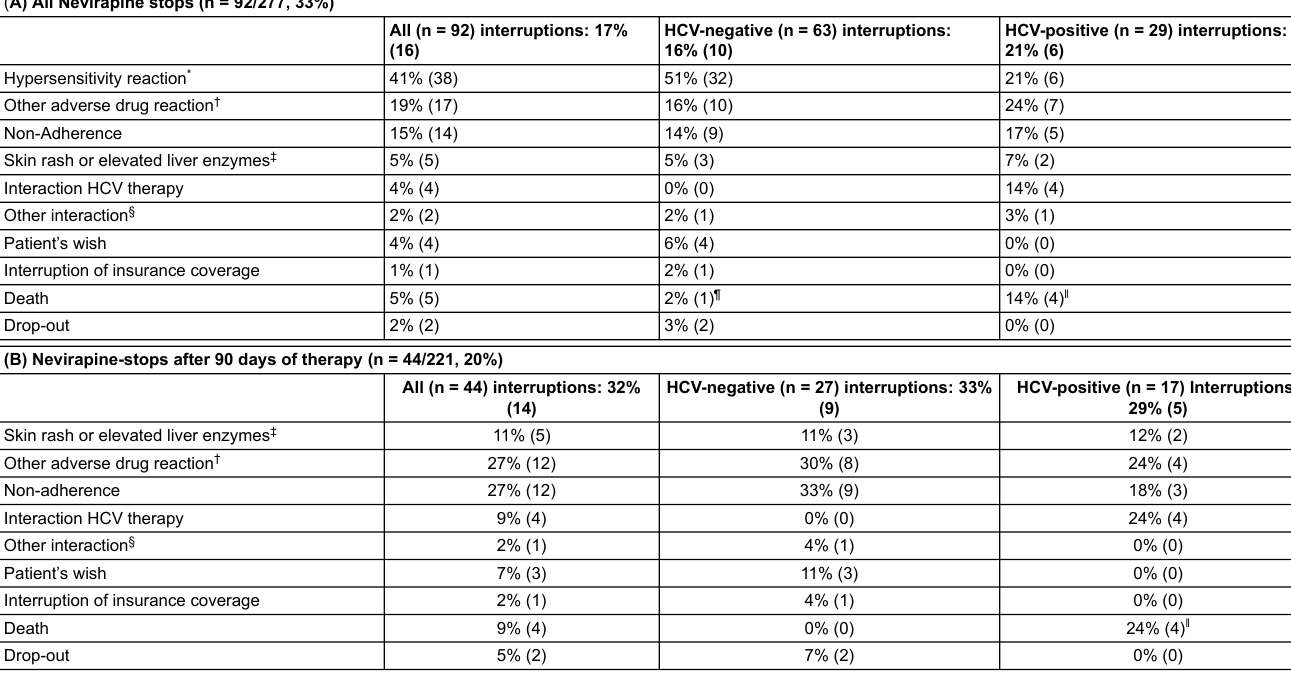
Table 3: Reasons for stopping or interrupting nevirapine therapies (after 1 Jan